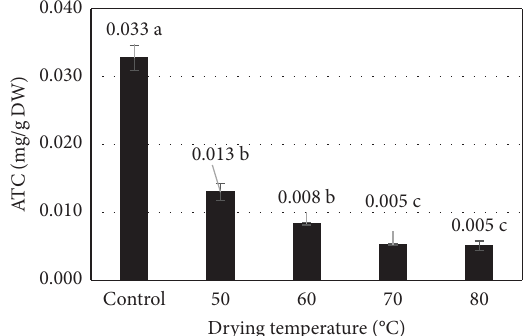
Figure 9: Efect of drying temperature on astaxanthin content.